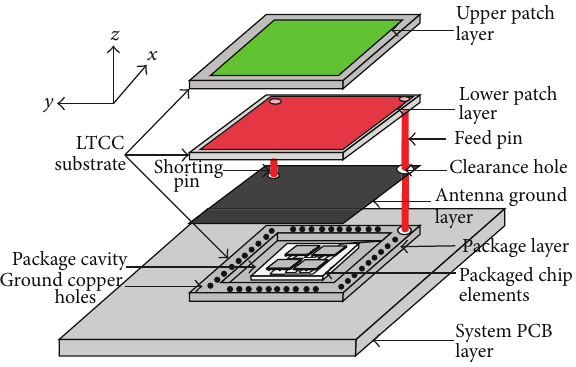
Figure 1: Expanded view of the proposed antenna integrated in